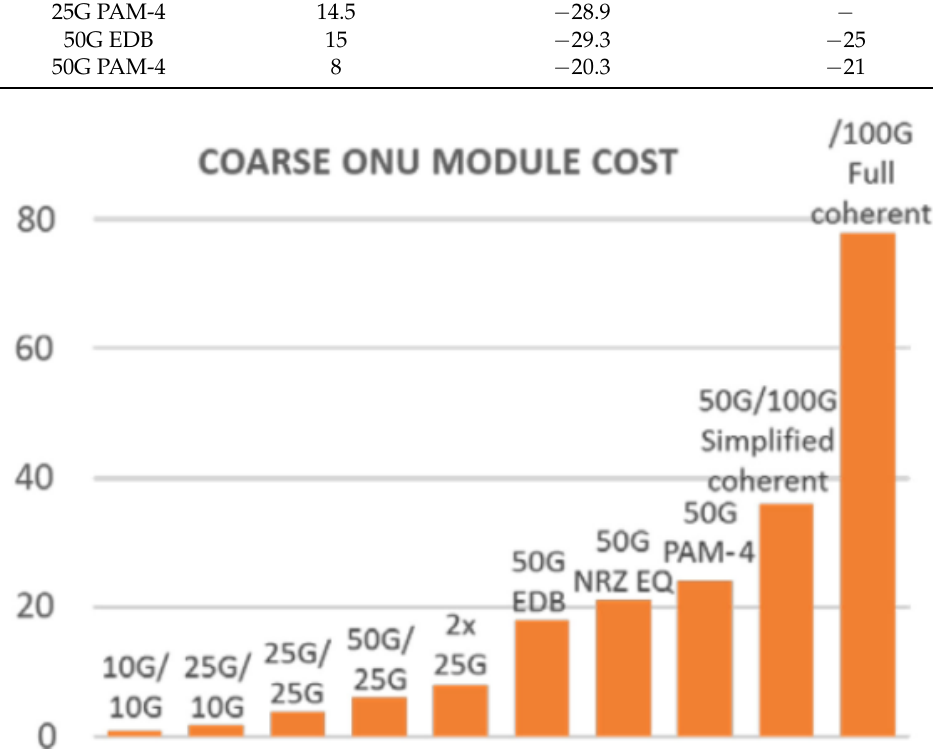
Figure 34. Comparison of various modulation formats in terms of cost [88].